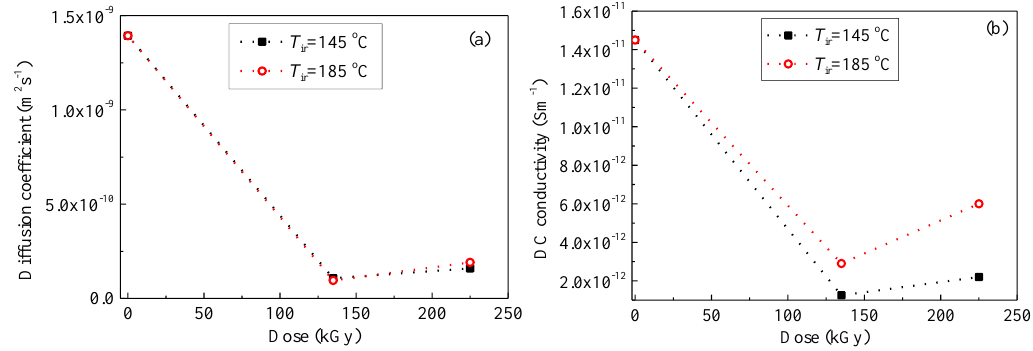
Figure 12. Diffusion coefficient D ( a ) and DC conductivity σ DC ( b ) as a function of dose calculated using experimental data obtained at 200 °C.